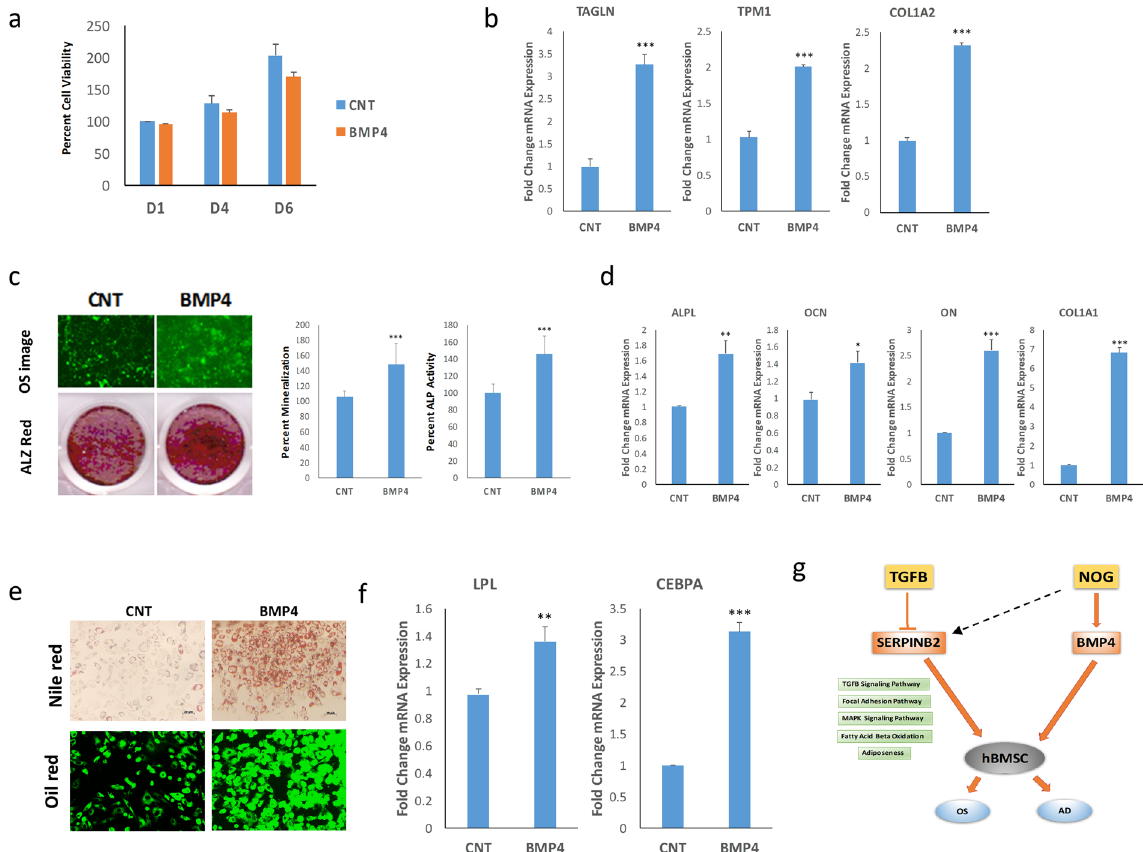
Figure 8. Effect of exogenous BMP4 on osteoblastic and adipocytic differentiation of hBMSC − Bone cells. ( a ) Quantification of cell viability of hBMSC − Bone cells in the presence or absence of recombinant BMP4. (b) qRT-PCR quantification for TAGLN, TPM1, and Col1A2 in hBMSC − Bone cells in the presence or absence of recombinant BMP4. The expression of each target gene was normalized to GAPDH. Data are presented as mean ± SD from three independent experiments, n = 9; *** p < 0.0005. (c) OsteoImage ™ staining (20 × magnification) of hBMSC − Bone cells which were induced into the osteoblast in the presence or absence of recombinant BMP4. The lower panel shows Alizarin Red S staining. The quantification of mineralized matrix formation for vehicle or recombinant BMP4-treated hBMSC − Bone cells is shown (right panel). Data are presented as relative mean mineralization ± SD from three independent experiments, n = 9; * p < 0.0005. (d) qRT-PCR quantification of ALPL, OCN, ON, and and COL1A1 osteogenic markers in hBMSC − Bone cells in the presence or absence of recombinant BMP4 under osteogenic induction conditions. The expression of each target gene was normalized to GAPDH. Data are presented as the means ± SD from three independent experiments, n = 9;, * p < 0.05 ** p < 0.005, *** p < 0.0005. (e) hBMSC − Bone cells were differentiated into adipocytes for 7 days under the indicated experimental conditions. Upper panel shows fluorescence Nile red staining of mature oil filled adipocytes (20 × magnification), whilst the lower panel shows Oil red O staining for adipocytes (20 × magnification). The lower panel shows the relative quantification of Nile red staining of mature oil-filled adipocytes. (f) qRT-PCR quantification for LPL and CEBPA adipocytic markers. The expression of each target gene was normalized to GAPDH. Data are presented as mean ± SD from three independent experiments, n = 9; ** p < 0.005, *** p < 0.0005. (g) Schematic model illustrating the convergence of BMP and TGF β in regulating hBMSC